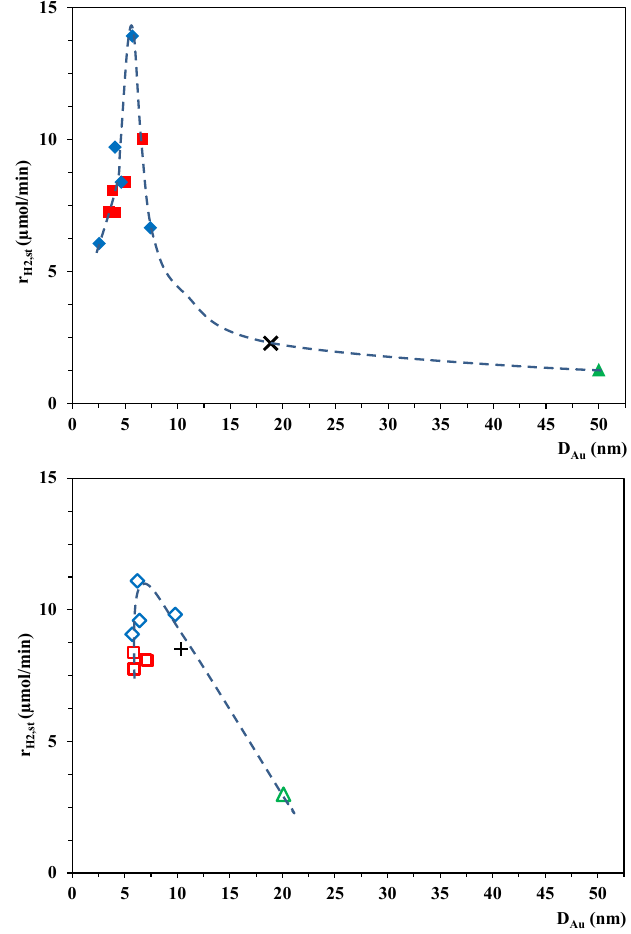
Figure 7. Average H 2 evolution rates as a function of average Au particle size on different Au-modified TiO 2 photocatalysts: ( a ) Aeroxide P25 TiO 2 -based samples (♦ Au-P25-CRIS, ■ Au-P25-CRSIM, ▲ Au-P25-PROA, × Au-P25-PRTC); ( b ) Kronos Vlp7000 TiO 2 -based samples (◊ Au-Kronos-CRIS, □ Au-Kronos-CRSIM, Δ Au-Kronos-PROA, + Au-Kronos-PRTC).